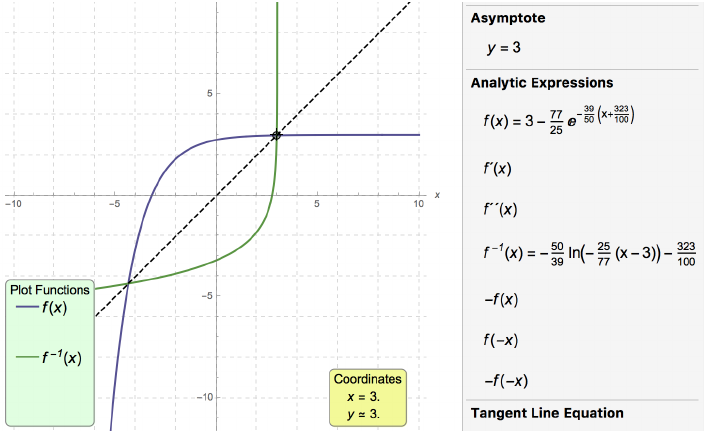
Figure 20. Image that illustrate the solution of the evaluation task that can be associated to Figure